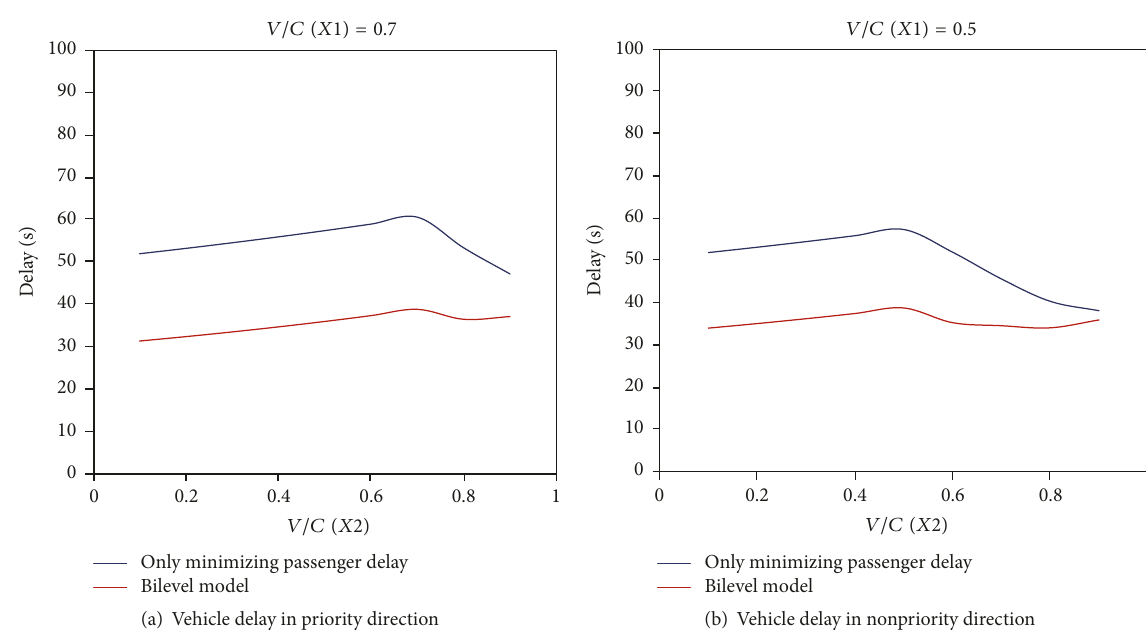
Figure 3: Vehicle delays of two directions with different transit occupancy.